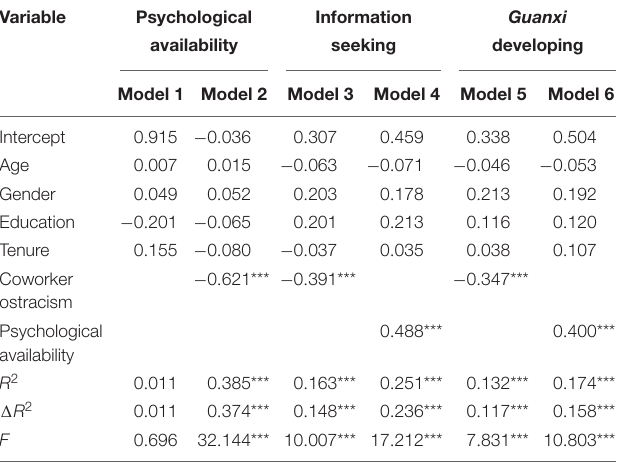
TABLE 3 | Results of multiple regression analysis.